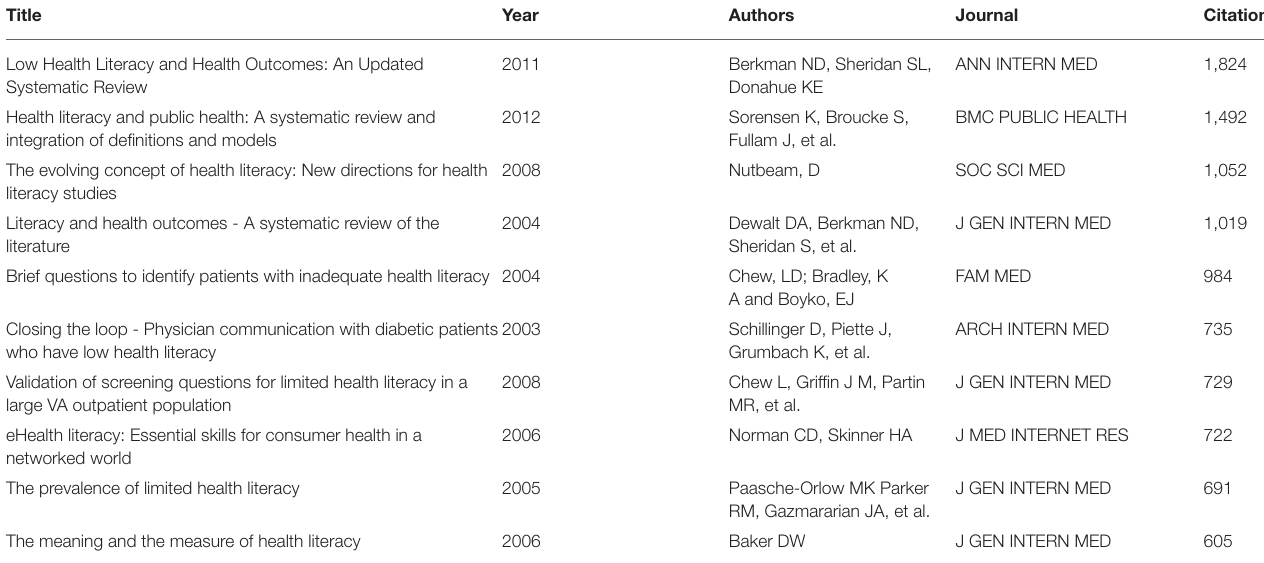
TABLE 5 | The top 10 papers with the most